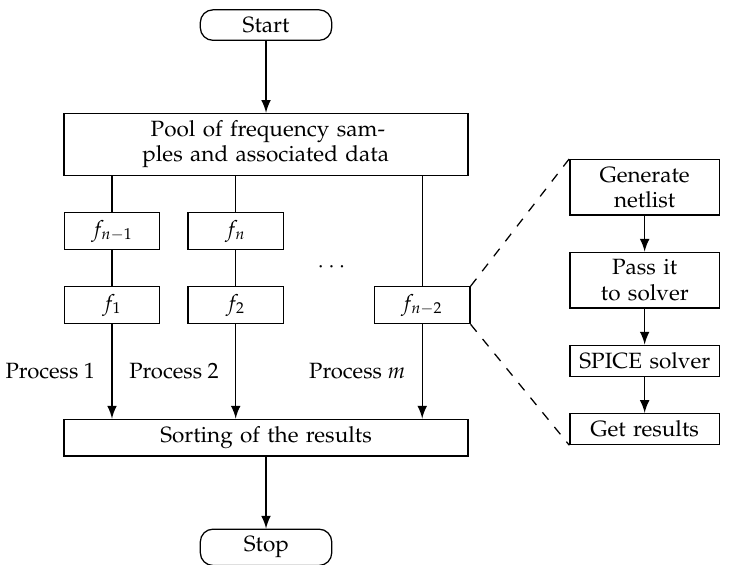
Figure 8. Asynchronous multiprocessing of n tasks in the frequency domain by m processes and recombination of the results